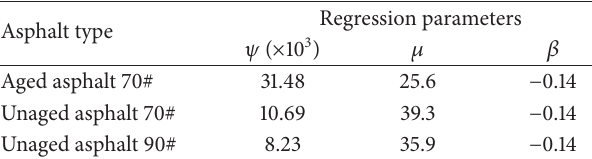
Figure 10: Rutting factor versus temperature for 70# virgin asphalt and WMA binder with 3% additive after short-term aging. Table 5: 𝜓 , 𝜇 , and 𝛽 of aged and unaged